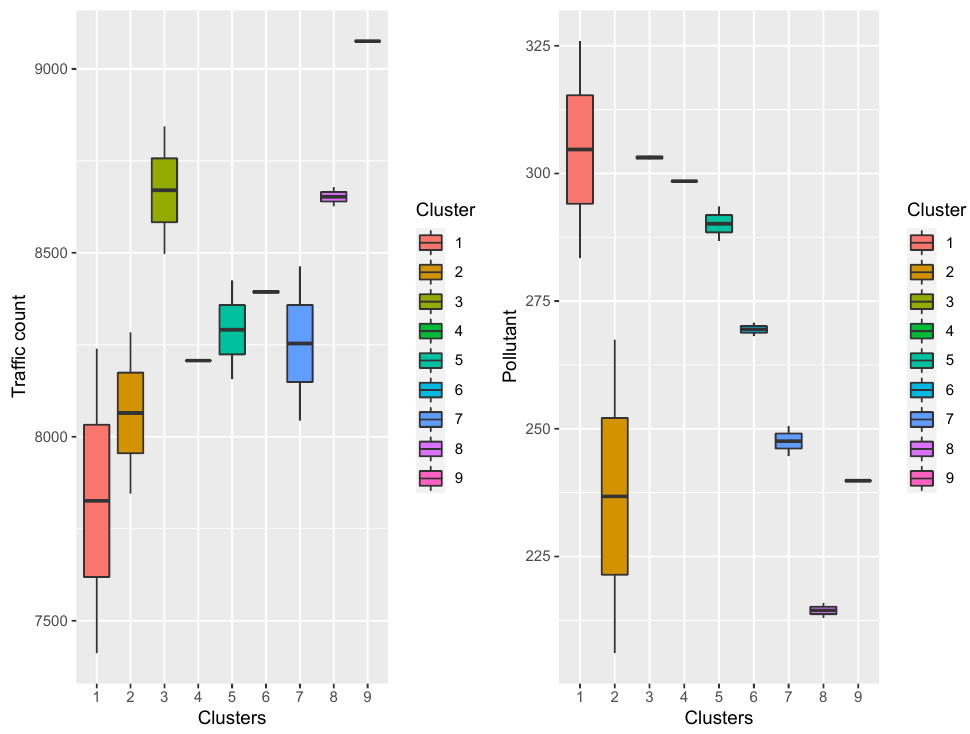
Figure 19. Clustering results applied to several weeks of data and visualization of CO and traffic data. Figure 20 shows four clusters for the NO 2 pollutant. One can see that for Cluster 1, Cluster 2 and Cluster 4, the distribution of the level of traffic and amount of emitted NO 2 is completely different, which is not the case for the Cluster 3. Globally, the amount of NO 2 tends to be as high as the traffic level.